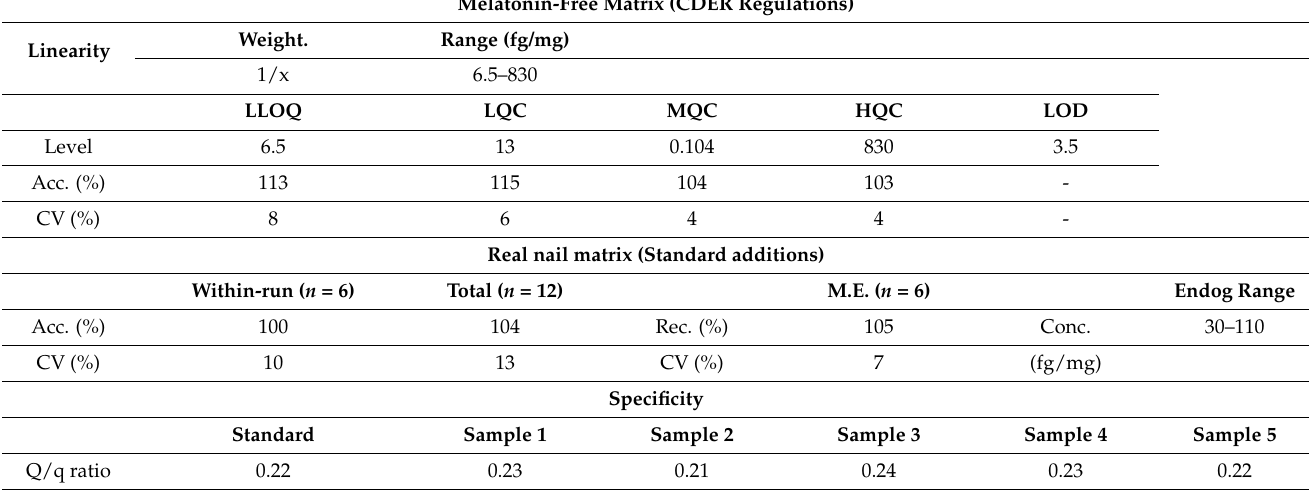
Table 1. Method validation parameters in melatonin-free matrix and real nail matrix. Calculated melatonin-free matrix parameters were linearity (in terms of weighting and range), LLOQ, LQC, MQC, HQC and LOD (in terms of accuracy and CV). Calculated real nail matrix parameters were within-run and total accuracy and CV; matrix effect (in terms of recovery and CV); the endogenous range of selected samples’ melatonin; and specificity of the method by comparing standard and samples. Units of range, level, LOD and concentration are